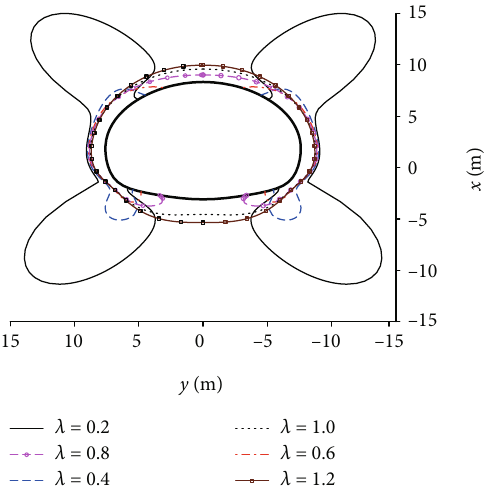
Figure 10: The plastic zone predicted by the analytical solution for λ = 0 : 2 , λ = 0 : 4 , λ = 0 : 6 , λ = 0 : 8 , λ = 1 : 0 , and λ = 1 : 2